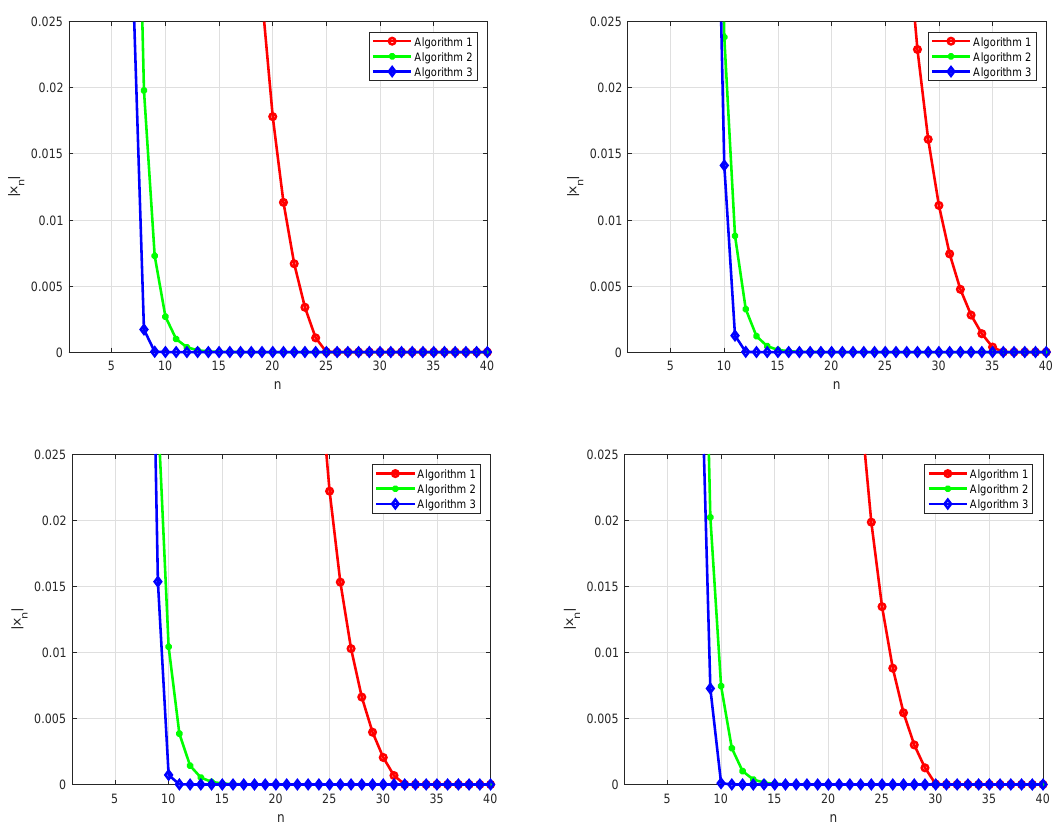
Algorithm 1 Algorithm 2 Algorithm 3